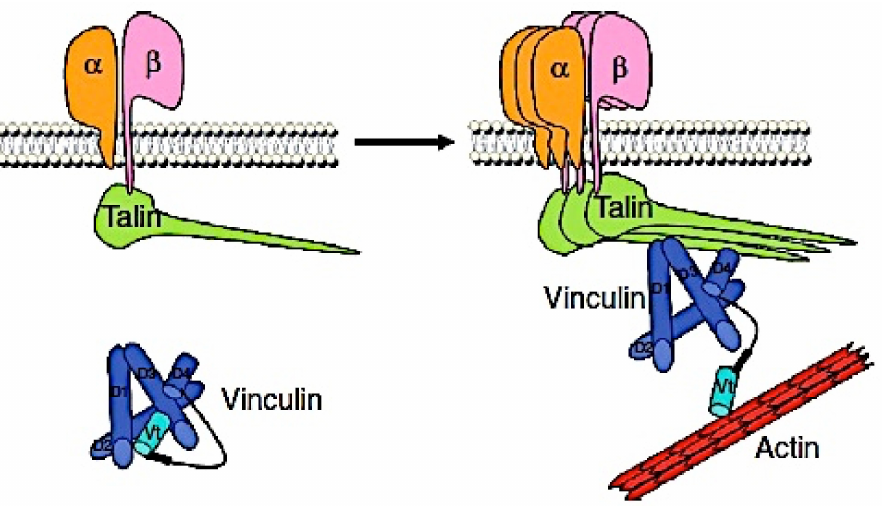
Figure 1. The vinculin and talin-1 interaction regulate integrin clustering at focal adhesions (This figure was adapted from Peng X et al.